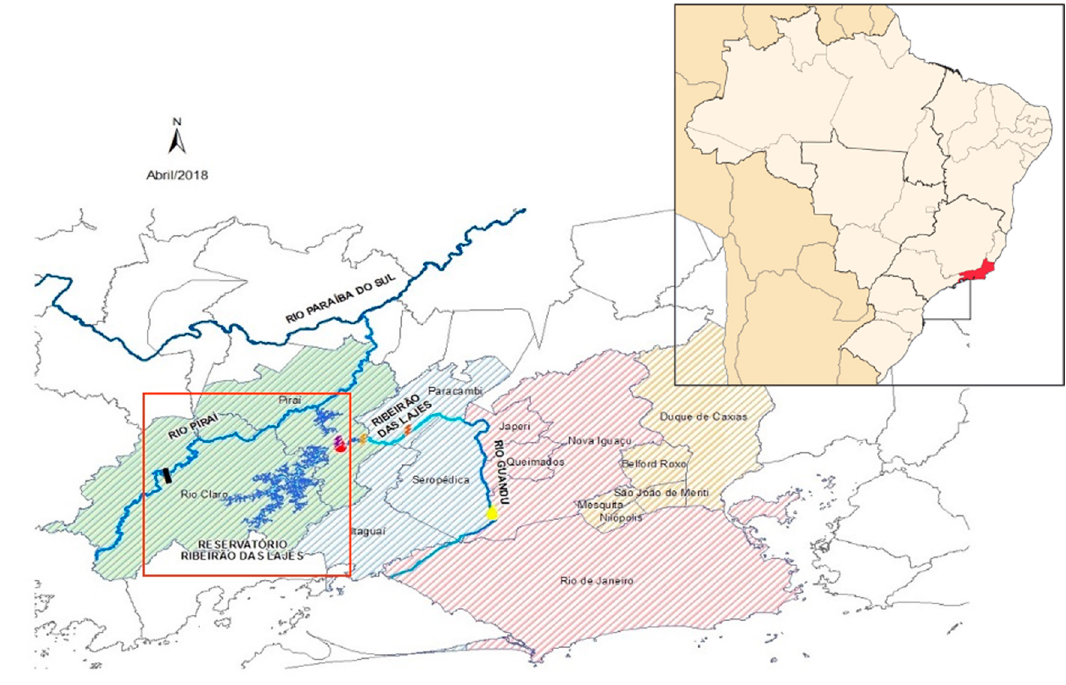
Figure 1. Basin of Guandu river’s hydrographic region.